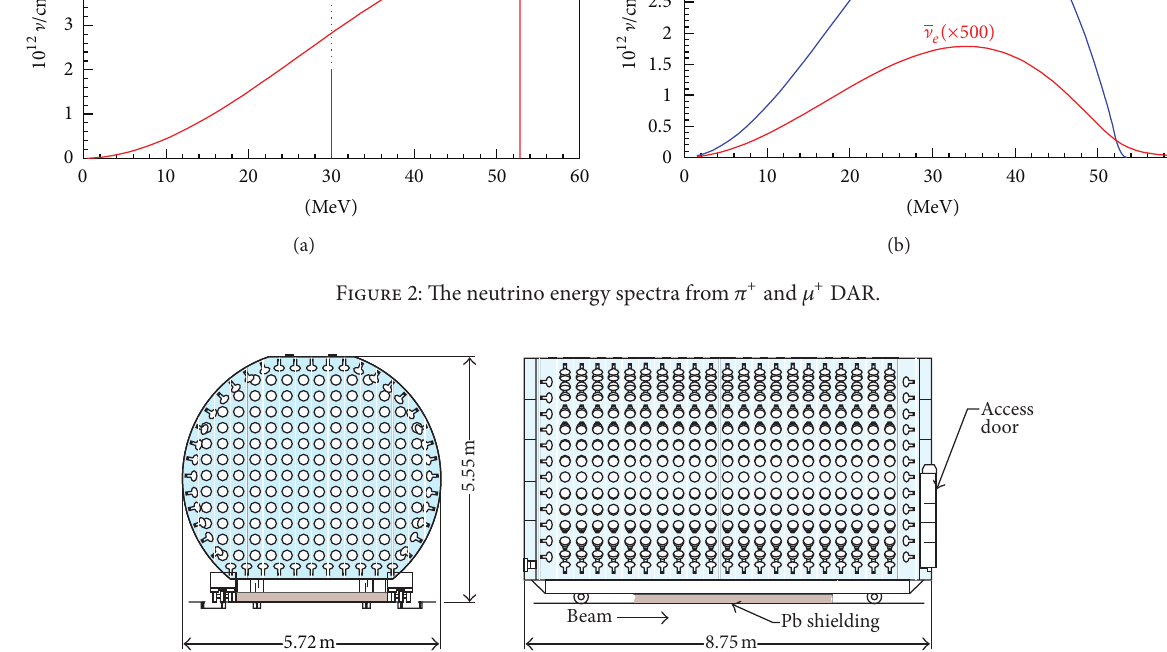
Figure 3: A schematic drawing of the LSND detector.